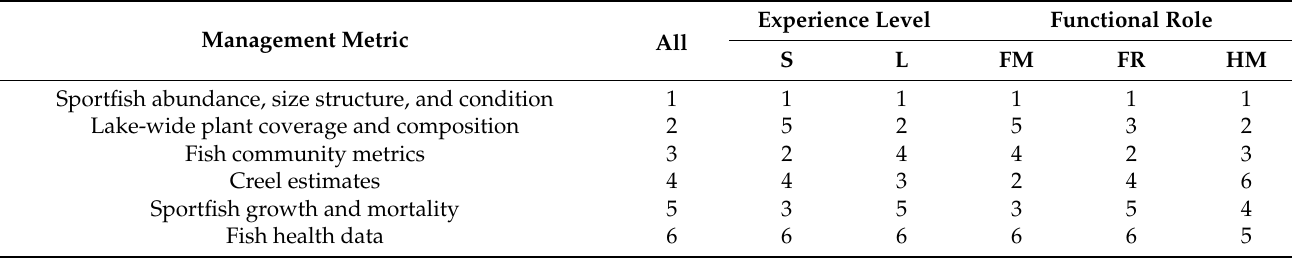
Table 3. Weighted rank of importance of six categories of metrics for freshwater resource management with data pooled (all) and organized by experience level (short-tenured, S, ≤ 5 years; long-tenured, L, >5 years) and functional role (fisheries management, FM; fisheries research, FR; habitat management, HM). For ease of interpretation, priority is listed here in order from 1 (largest weighted ranking value and highest priority) to 6 (smallest weighted ranking value and lowest